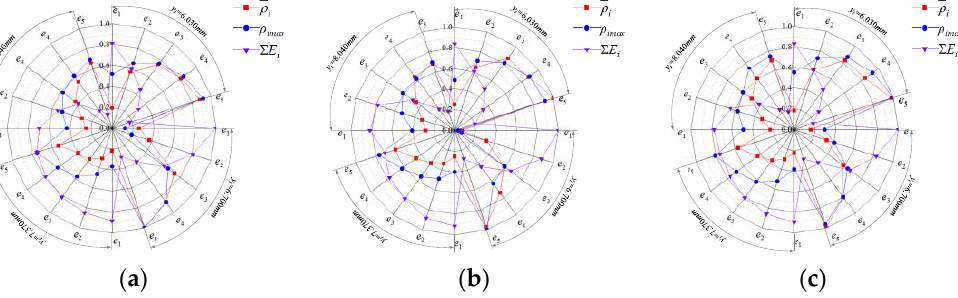
Figure 11. Friction wear energy density distribution of three blades of scheme 1: ( a ) tooth 1; ( b ) tooth 2; ( c ) tooth 3.